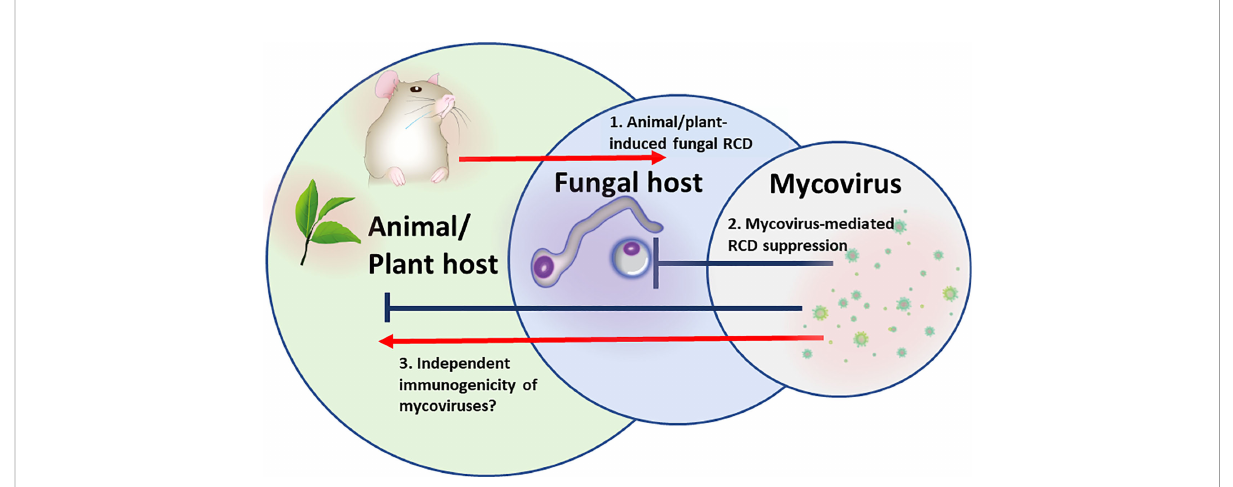
FIGURE 1 The “ Russian doll ” model of multipartite RCD-driven pathosystem: Mycovirus, fungal pathogen, animal/plant host. 1. Animal/plant host induction of regulated cell death (RCD) pathways in the fungus to eliminate fungal spread. 2. Mycoviral-mediated inhibition of RCD or activation of survival mechanisms in fungal cells to prevent fungal host cells from dying. 3.Mycoviral immunomodulation. Mycoviral proteins may serve as PAMPs sensed by animal/plant cell PRRs and directly stimulate or block multiple in fl ammatory and cell death signaling